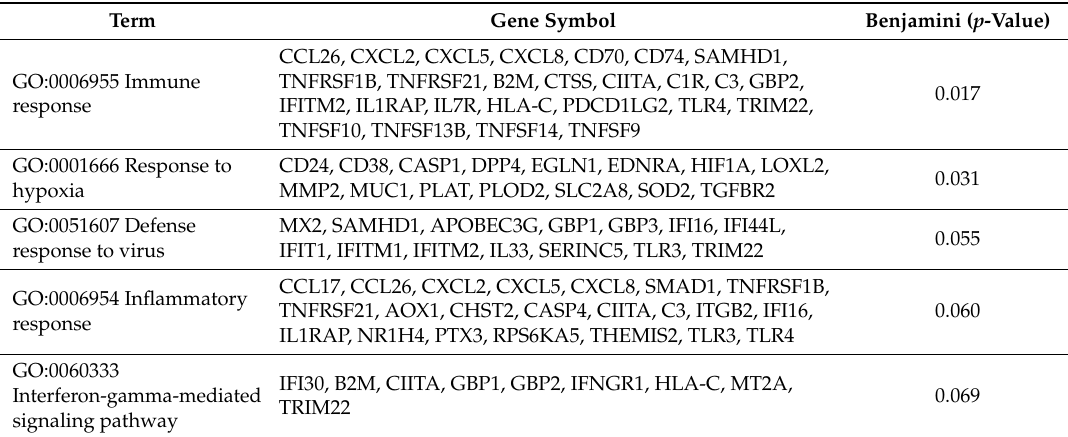
Table 1. List of the top ten Gene Ontology Biological Processes over-represented in the genes that are up-regulated in both the infected KO-1 and KO-2